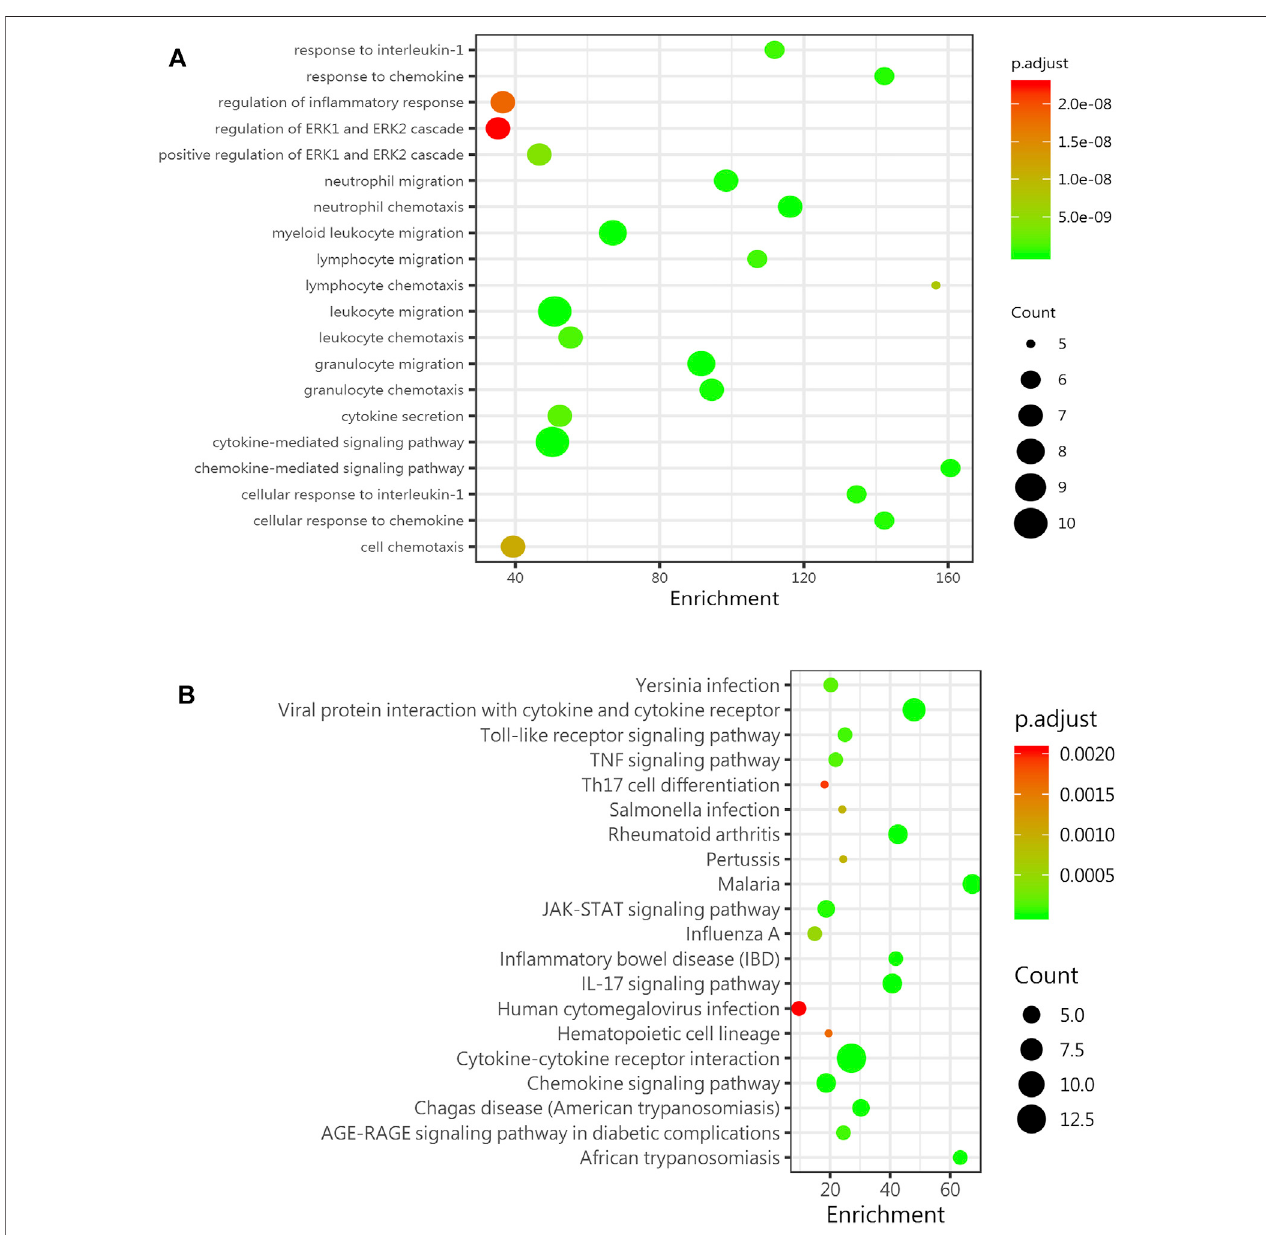
FIGURE5| GOand KEGGanalysespredictage-relatedsignalingpathways. (A) RepresentativeGO_BP (biological process) analysisofin fl ammatory factors inthe sera of mice in the young group (8-week-old mice) and the old group (78-week-old mice) ( n = 4). (B) KEGG enrichment analysis of DEGs among in fl ammatory factors in the sera of mice in the young group (8-week-old mice) and the old group (78-week-old mice) ( n = 4). Abbreviations: DEGs, differentially expressed genes.